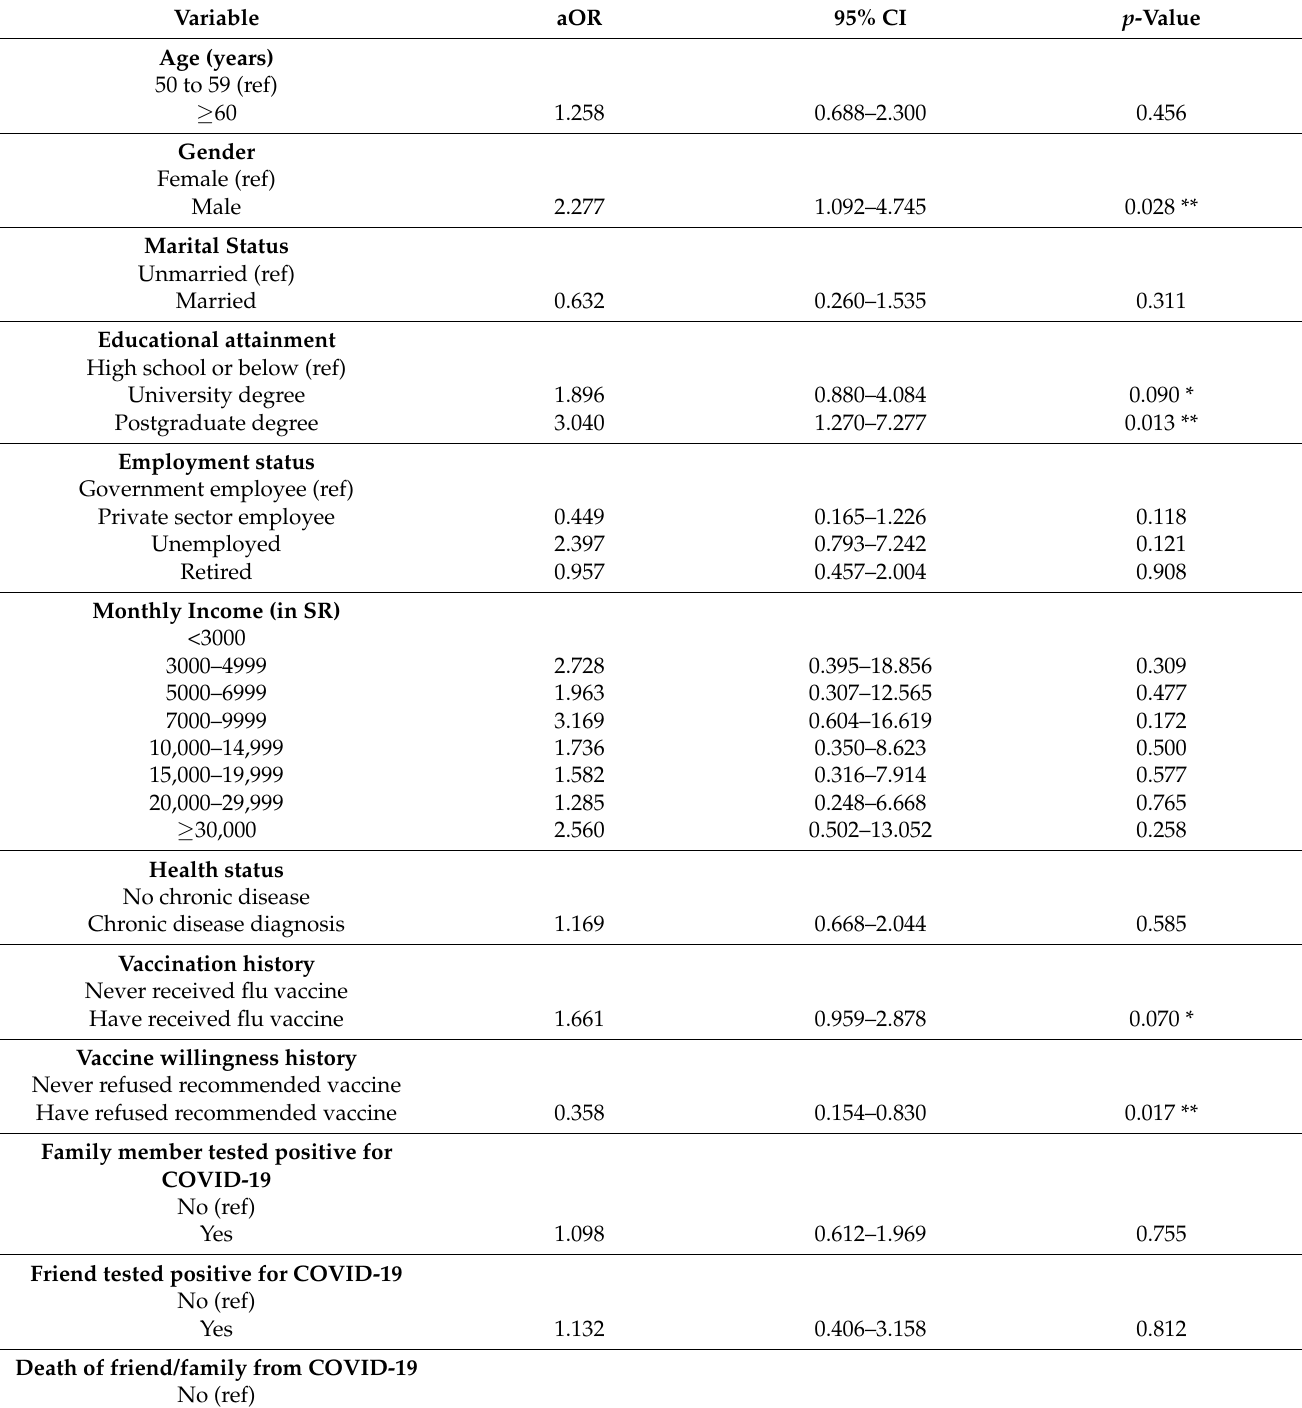
Table 2. Logistic regression estimates of factors associated with acceptance of COVID-19 vaccination among the older adults ( n =